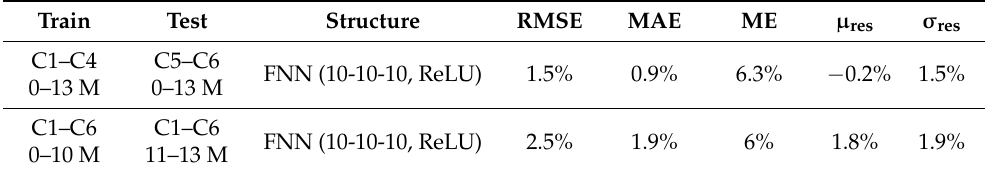
Table 6. Test results with impedance measurements at 90% SoC.